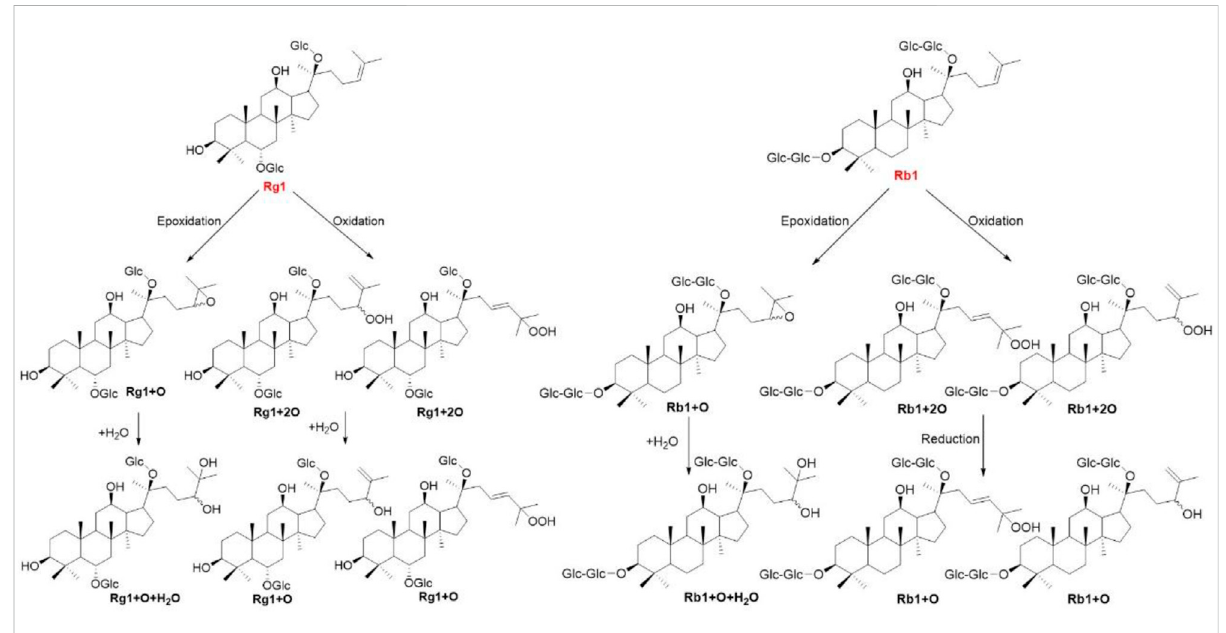
FIGURE 5 The oxygenated metabolites involved in in vivo biotransformation pathways of ginsenosides Rb1 and